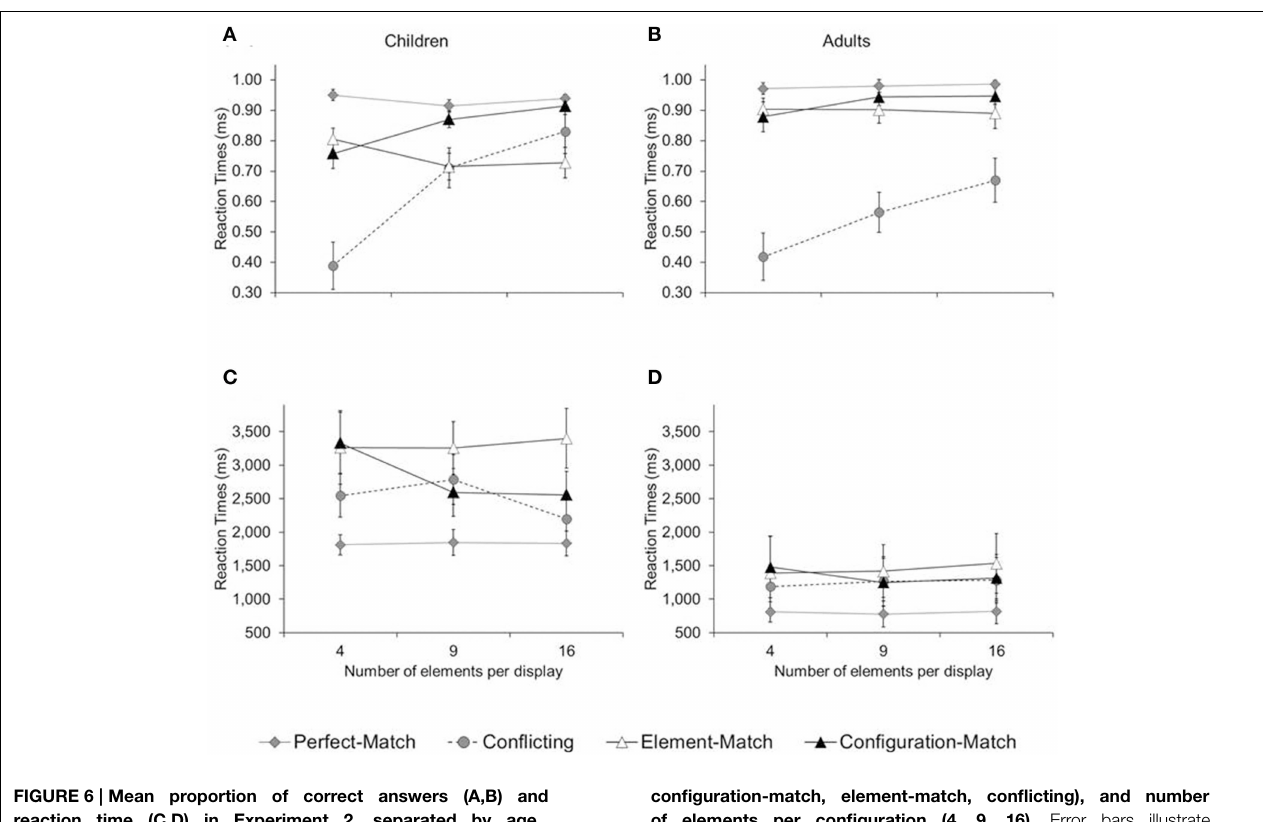
FIGURE 6 | Mean proportion of correct answers (A,B) and reaction time (C,D) in Experiment 2, separated by age group (children, adults), trial type (perfect-match,